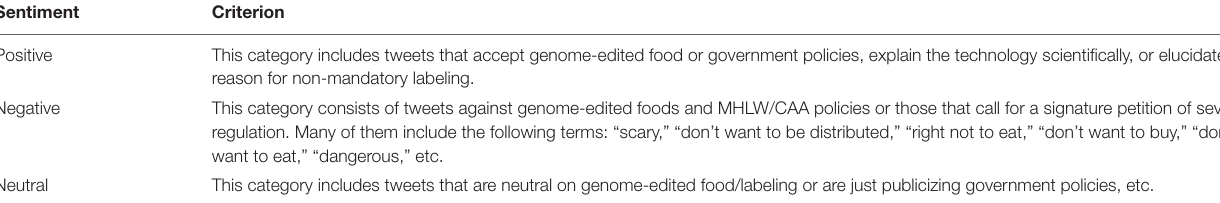
TABLE 1 | Tweet classification criteria for sentiment analysis. Sentiment